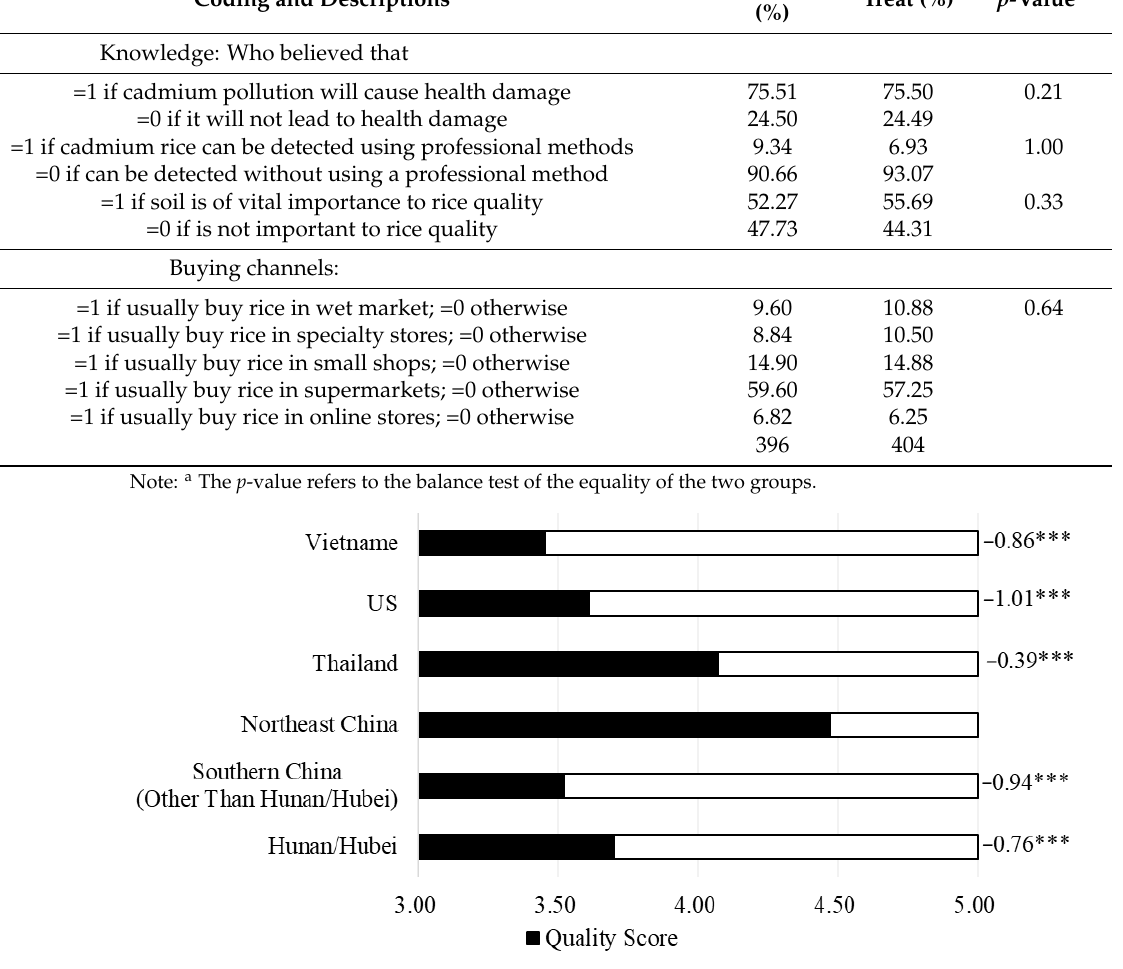
Figure 3. Quality scores by consumers for rice region of origin before the choice experiment. Note: The numbers and significance levels that follow the bar chart are the difference values between the region and the northeast rice score and the significant results of the Student’s t -test. *** Indicate p < 0.01.